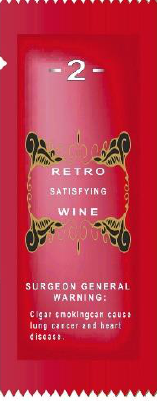
Figure 1. Hypothetical cigarillo package.